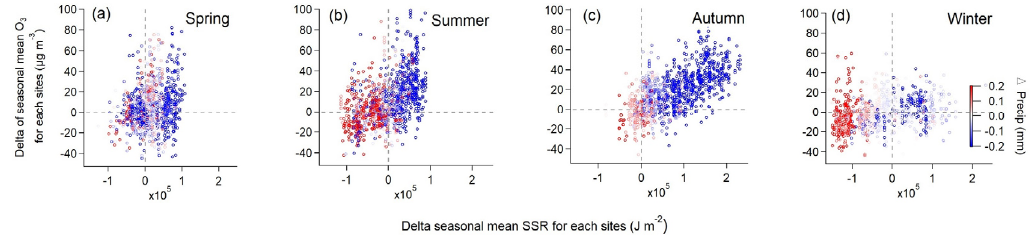
Figure 5. The difference in seasonal mean surface MDA8 O 3 between the two years as a function of the difference in seasonal averaged daily mean surface net solar radiation ( Δ SSR) at individual monitoring stations for all seasons. ( a ) spring, ( b ) summer, ( c ) autumn and ( d ) winter.